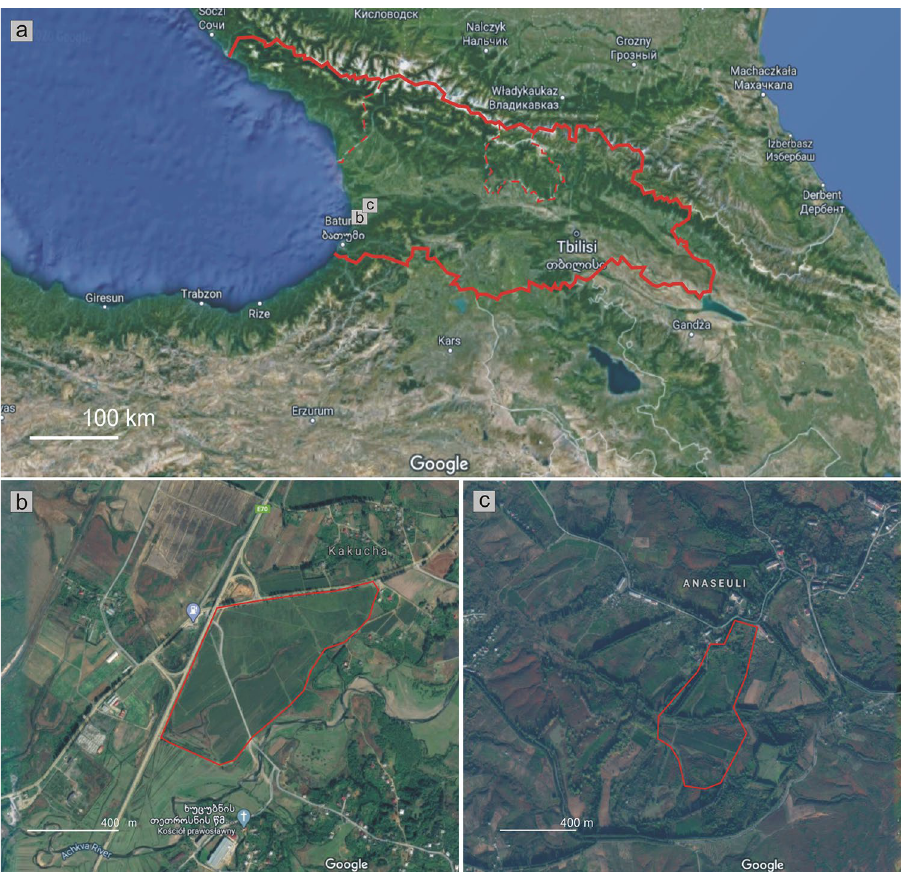
Figure 1. The location of the studied areas with regard to the borders of Georgia ( a ) and those of the studied tea plantations in Kobuleti ( b ) and Ozurgeti ( c ). Red dashed lines in ( a ) refer to Abkhazia and South Ossetia. Map was created on the basis of Google maps (https:// www. google. pl/ maps/ place/ Gruzja) by G. J. Wolski in the CorelDRAW 12.0 Graphic